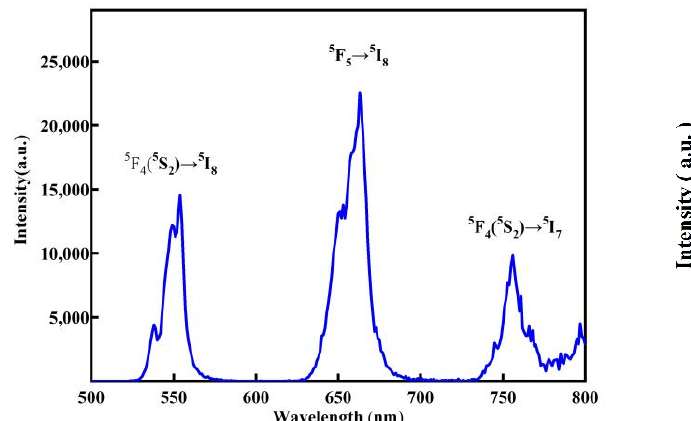
Table 6. The measured B 1 , B 2 , τ 1 , and τ 2 of the fluorescence lifetime for PMN-32PT:Ho 3+ /Yb 3+ . Transitions